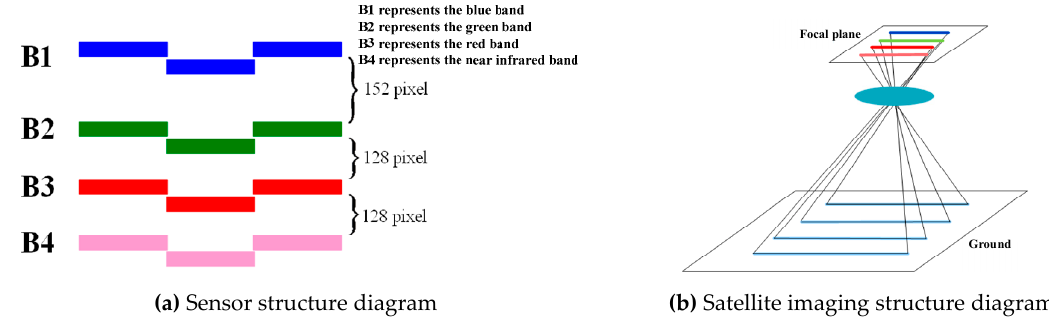
Figure 3. Diagram of satellite microvibration detection based on star map.